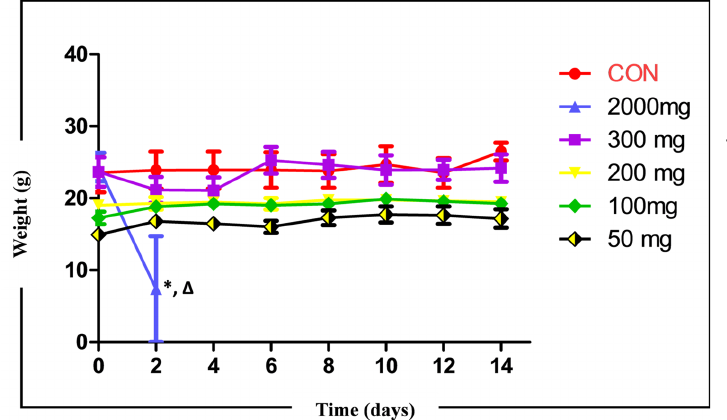
Figure 2. Evaluation of body mass of animals treated with different doses of aqueous extract from leaves of M. ferruginata . CON= control group. ANOVA, Dunn’s post hoc test, *p <0.001; ∆ - death of